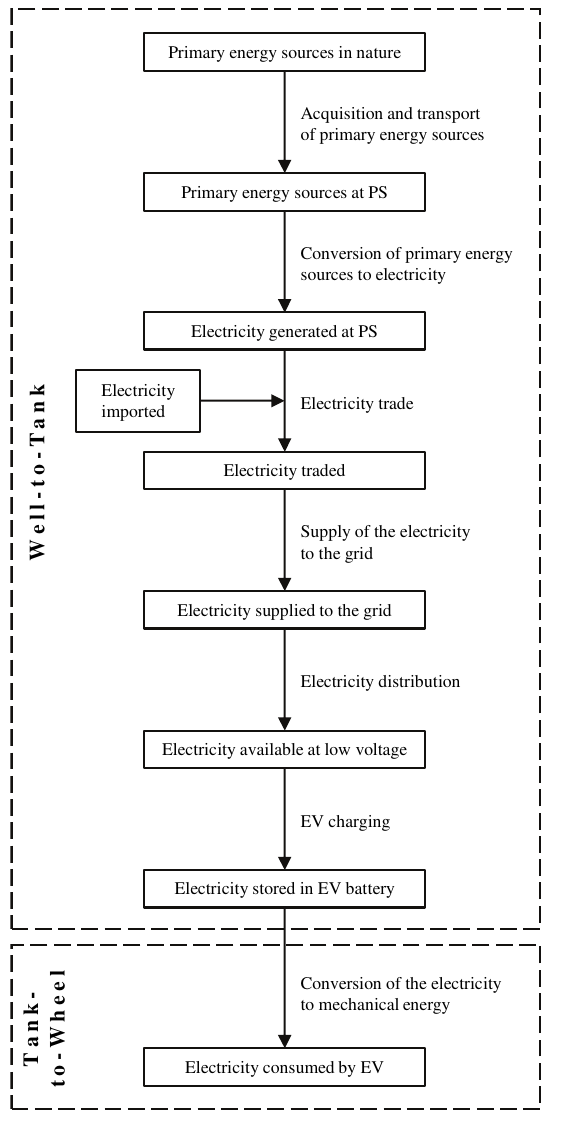
Fig. 4. Stages of the WtW analysis considered in the study; PS – power station The general research methodology has been adopted